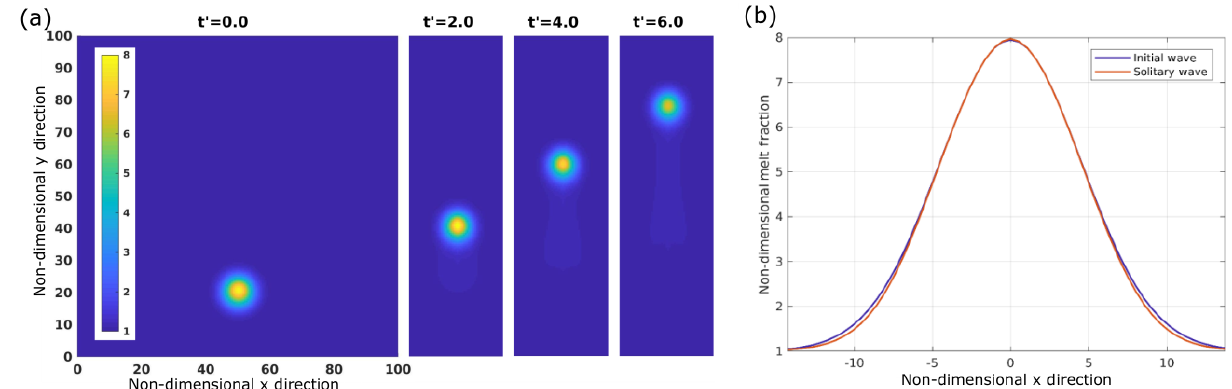
Figure 2. (a) Non-dimensional melt fraction at four different time steps during the ascent of a solitary wave with an initial amplitude of 8. The model was carried out for a melt network geometry consisting of 100% films and an aspect ratio of 0.1. The background porosity is 0.005 and n = 3. (b) Horizontal cross section through the center of the initial wave and the solitary wave at a later time.